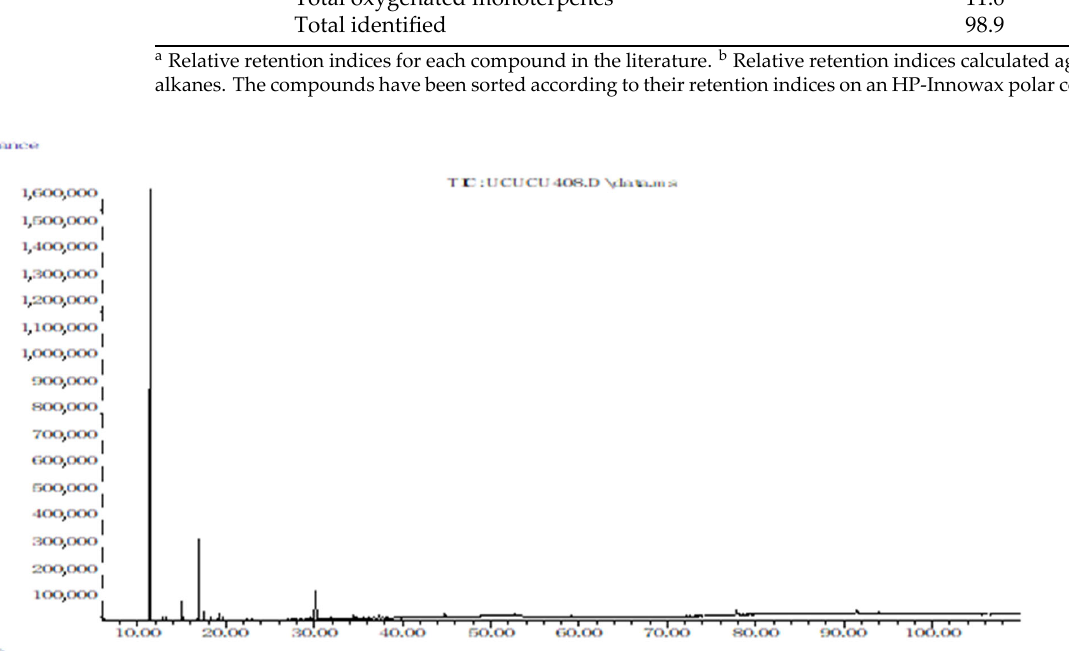
Figure 2. Total ion chromatogram of essential oil from root of Chrysopogon nigritanus.